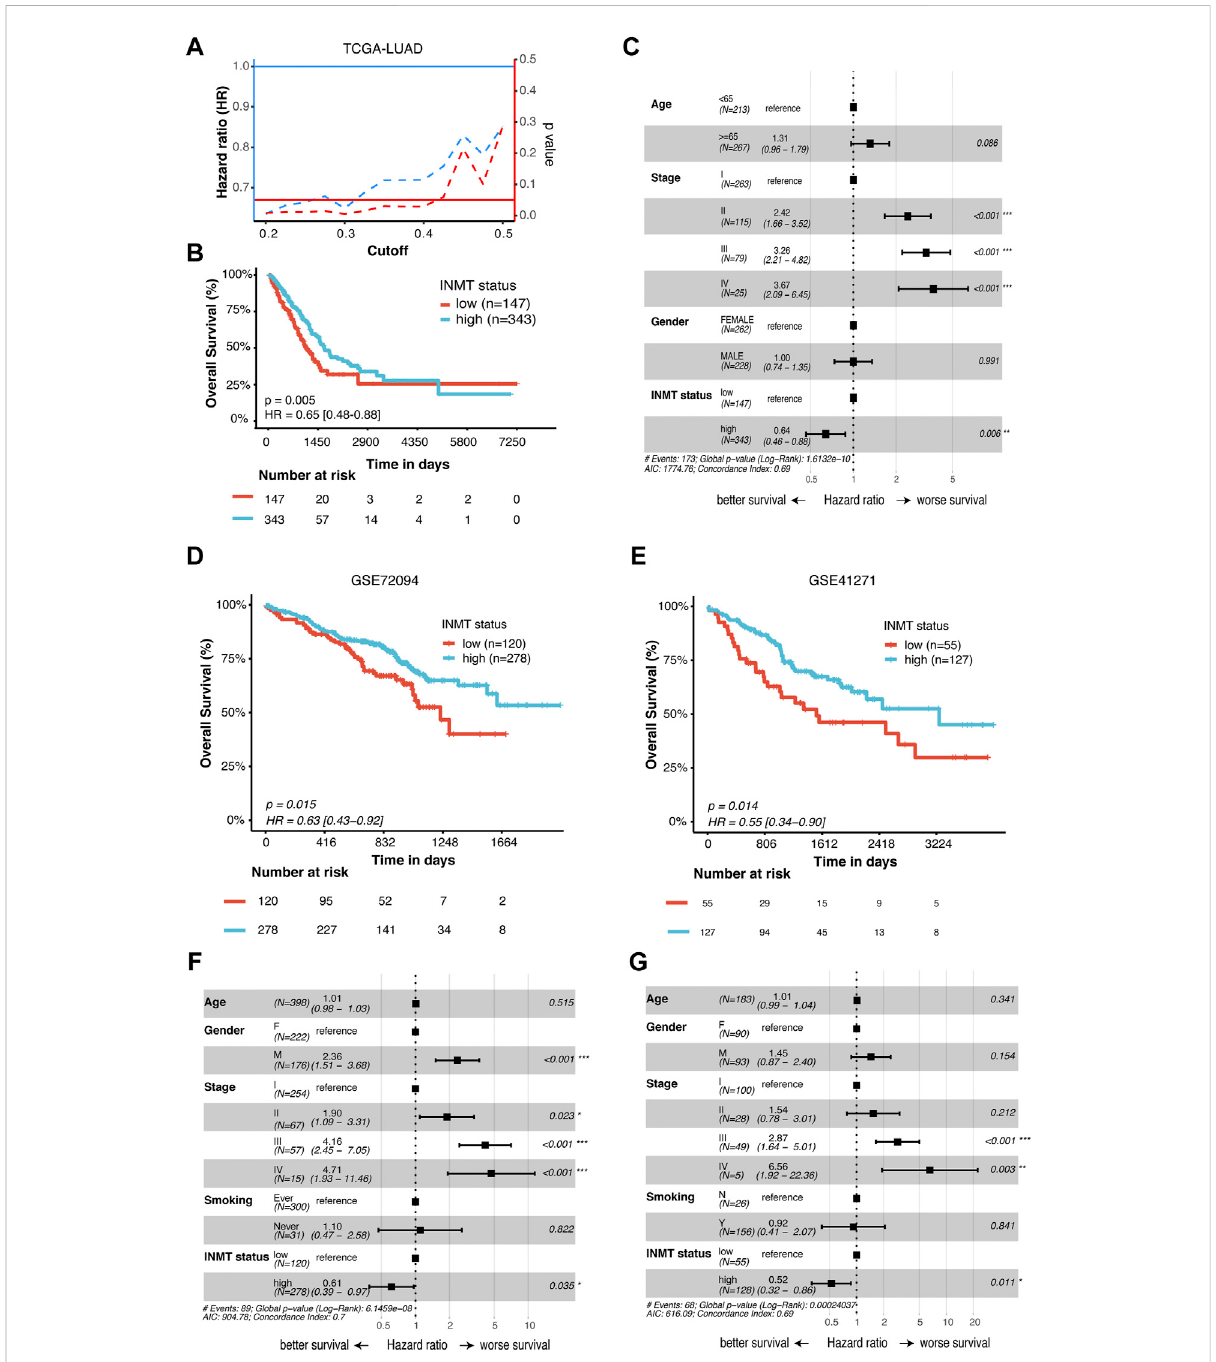
FIGURE 3 Prognostic signi fi cance of INMT in LUAD patients. (A) Hazard ratio (HR) and statistical results of the INMT high-expression group versus low- expression group at different cutoffs in TCGA-LUAD cohort. The blue dashed line represents the HR value, the red dashed line represents the p -value, and the solid red line represents p = 0.05. (B) Kaplan – Meier curve analysis of the prognostic signi fi cance of high- and low-expression of INMTinTCGA-LUADcohorts. (C) MultivariateCoxanalysisoftheclinicalcharacteristicsandINMTassociatedwithoverallsurvival(OS)inTCGA- LUAD cohort. (D,E) Kaplan – Meier curve analysis of the prognostic signi fi cance of high and low expression of INMT in two GEO-LUAD cohorts (GSE72094andGSE41271),respectively. (F,G) MultivariateCoxanalysisoftheclinicalcharacteristicsandINMTassociatedwithOSintwoGEO-LUAD cohorts(GSE72094andGSE41271),respectively.Thecutoffof30%quantilewasusedtodividepatientsintolow-andhigh-expressiongroups.LUAD, lung adenocarcinoma; HR, hazard ratio; OS, overall